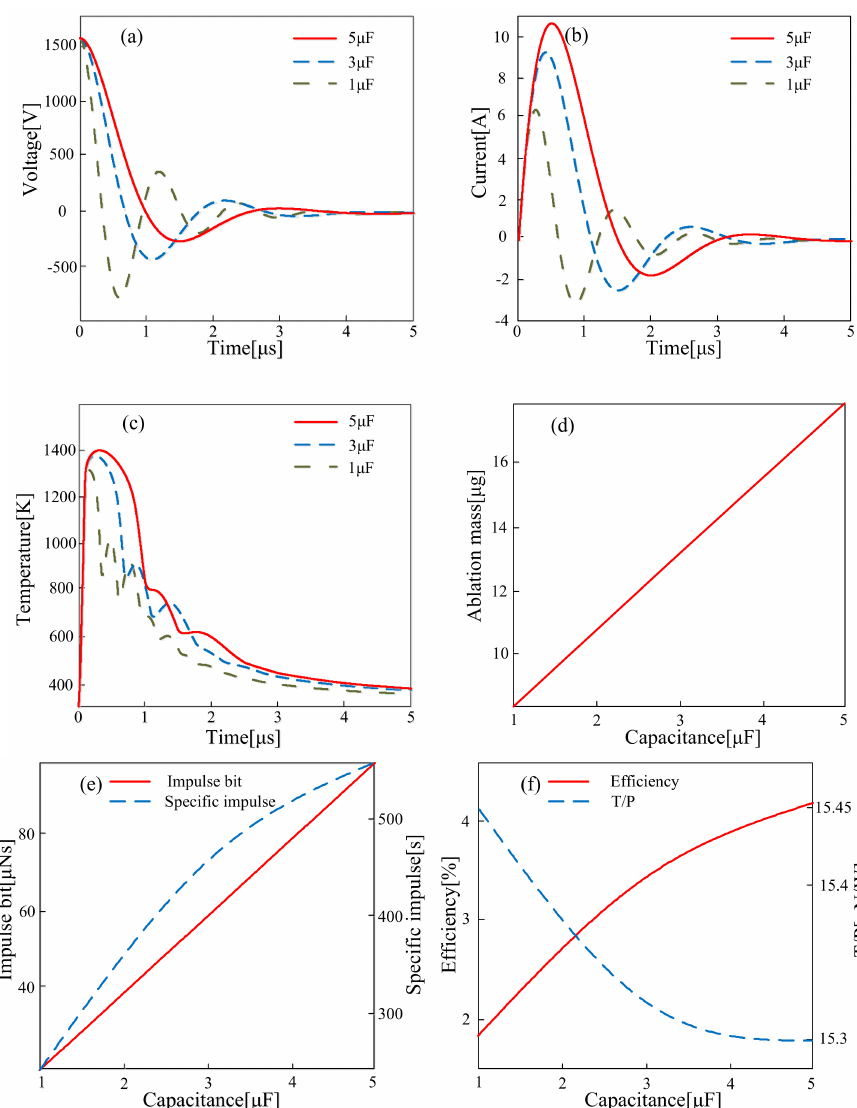
Figure 8. Simulation results at different capacitances: ( a ) Discharge voltage waveform; ( b ) discharge current waveform; ( c ) variation of ablation surface temperature with time; ( d ) variation of ablation mass with capacitance; ( e ) variation of impulse bit and specific impulse with capacitance; and ( f ) variation of efficiency and ratio of thrust to power with